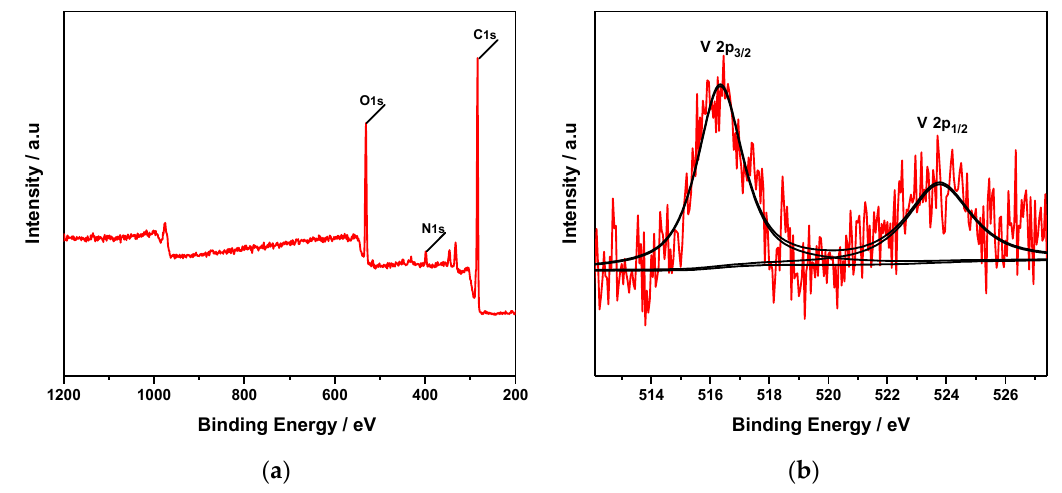
Figure 4. XPS spectra of UiO-67-KVO(O 2 ) 2 ( a ) and V 2p of UiO-67-KVO(O 2 ) 2 ( b ).